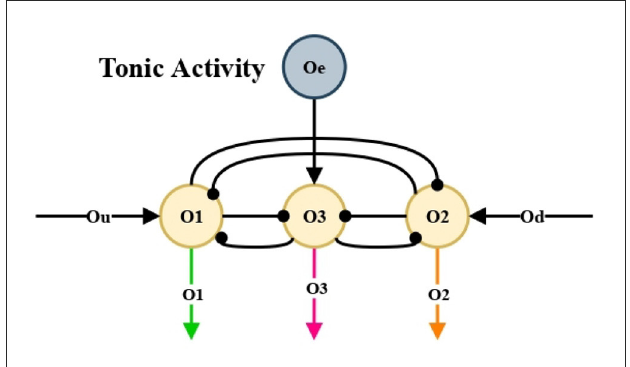
FIGURE5 Competitive neural network. Class winner-take-all (WTA).